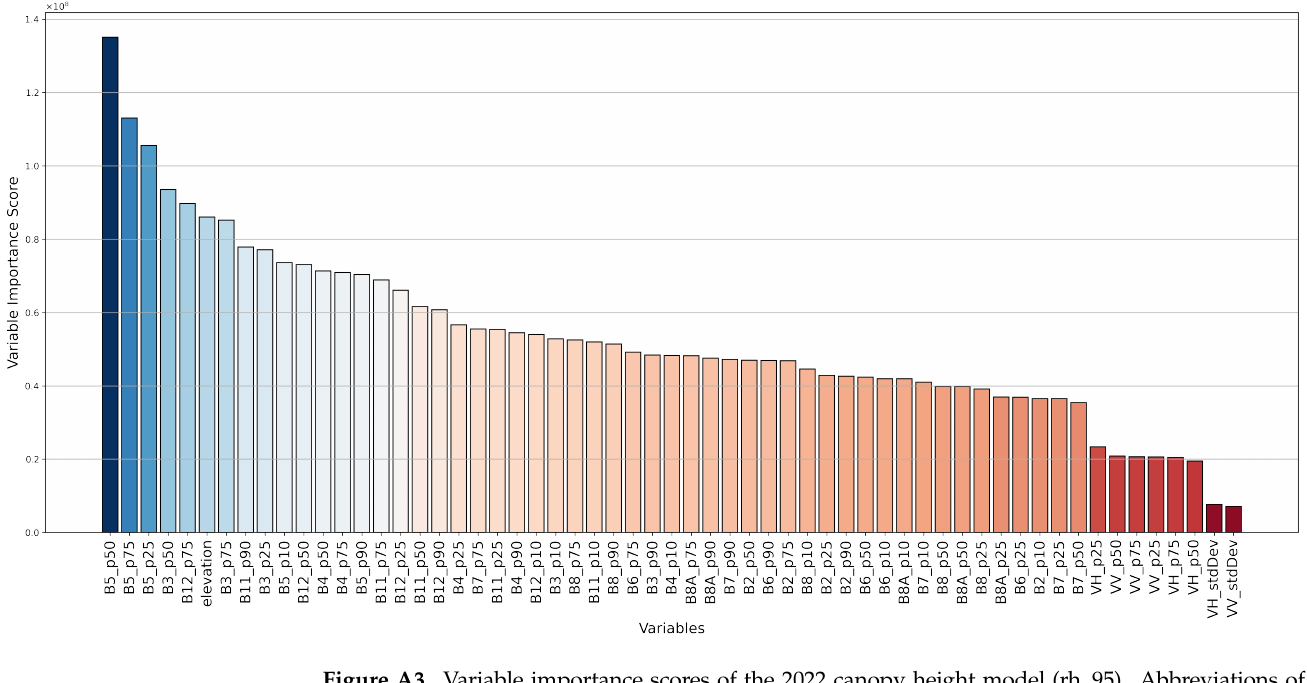
Figure A3. Variable importance scores of the 2022 canopy height model (rh_95). Abbreviations of sensors: Sentinel-1 (VV = vertical-vertical polarization, VH = vertical-horizontal polarization), Sentinel-2 (B*, e.g., B5, https://developers.google.com/earth-engine/datasets/catalog/COPERNICUS_S2_SR_ HARMONIZED, accessed on 12 February 2023). SRTM (elevation). Temporal statistics are abbreviated as follows: “p50” (50th percentile), “stdDev” (standard deviation).